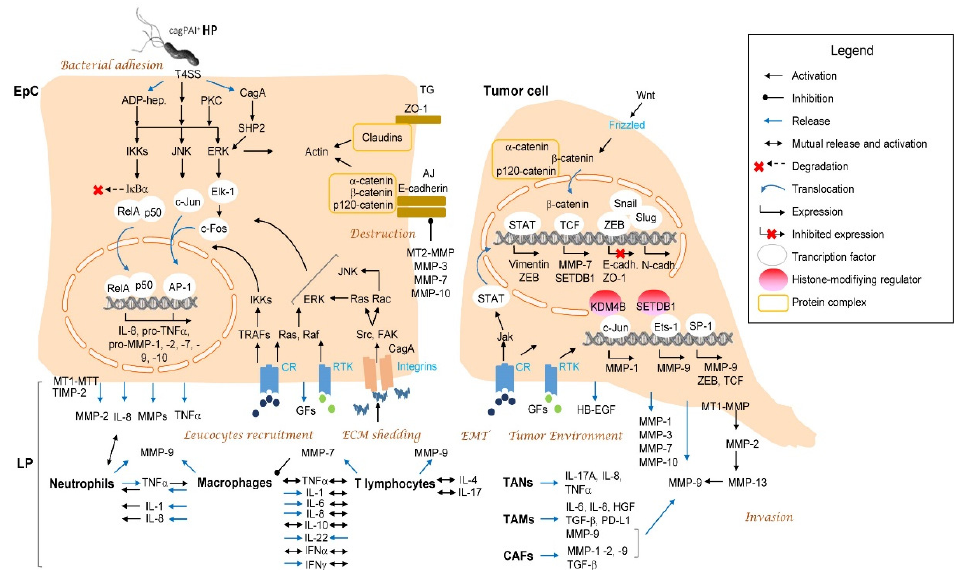
Figure 1. Signaling pathways pivotal for MMPs expression and MMPs-related processes in gastritis and gastric cancer. In tumor cell, the NF- κ B, JNK and ERK MAPK pathways activated in response to H. pylori and cytokines are not shown for simplicity. The transcription factors and their regulators important for expression of the EMT-related genes and discussed in the review are depicted in the tumor cell. The immune cells are recruited to the tissue and release a big number of mediators, including MMPs. MMPs from different cells populations activate each other, participate in matrix remodeling, regulate focal adhesion complexes and shed proteins in cellular junctions. It leads to disturbances in the cellular contacts and restructures actin, which impacts the cellular motility. MMPs can also activate cytokines and growth factors embedded within the extracellular matrix. In the tumor microenvironment, both cancer cells and tumor-associated immune cells keep producing the growth factors and MMPs, supporting the motility and invasion of tumor cells. AJ, adherens junctions; GFs, growth factors; CR, cytokine receptor; ECM, extracellular matrix; EMT, epithelial–mesenchymal transition; EpC, epithelial cell, HP, H. pylori ; LP, lamina propria; RTK, receptor tyrosine kinase; TGs, tight